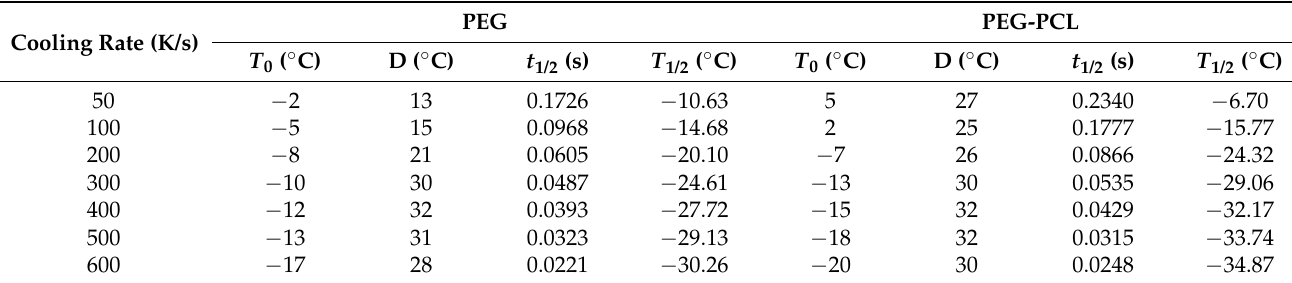
Figure 3. ( a ) PEG ( b ) PEG-PCL relative crystallinity curve with temperature. The values of T 0 (initial crystallization temperature), D (crystallization temperature range), t 1/2 (half-time of crystallization) and T 1/2 (half-temperature of crystallization) of PEG and PEG-PCL are listed in Table 1 when the crystallization rate is 50 K/s, 100 K/s, 200 K/s, 300 K/s, 400 K/s, 500 K/s, and 600 K/s. In the entire non-isothermal crystallization process, the crystallization time and the corresponding temperature have the following relationship [12]: Table 1. T 0 , D(K), t 1/2 , T 1/2 values of PEG and PEG-PCL at different cooling rates.